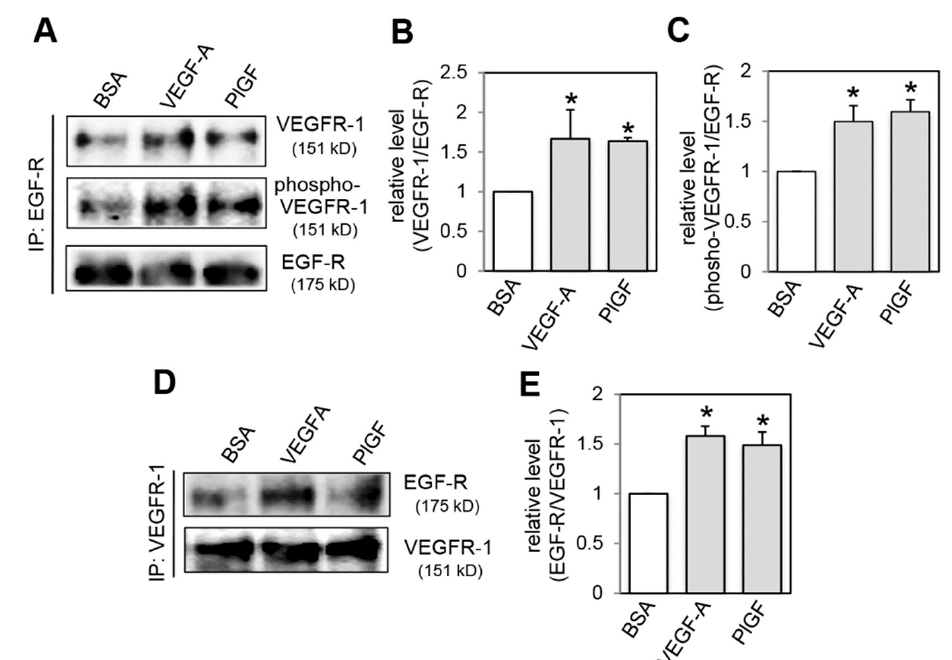
Figure 4. VEGFR-1 activation increases complex formation of VEGFR-1 and EGF-R. ( A ) Cells were treated with BSA, VEGF-A or PlGF for 30 min. Cell lysates were immunoprecipitated with an anti-EGF-R antibody (IP: EGF-R) and then immunoblotted for VEGFR-1 ( A , upper panel) and for phosphorylated VEGFR-1 ( A , middle panel). In parallel, Western blot was performed to control for EGF-R concentration in the immunoprecipitates ( A , lower panel). ( B , C ) Quantification of co-immunoprecipitated VEGFR-1 levels ( B ) and phosphorylated VEGFR-1 levels ( C ) normalized to immunoprecipitated EGF-R levels from three independent experiments. * p < 0.01, statistically significant increase compared with the BSA-treated control. ( D ) Cells were treated with BSA, VEGF-A or PlGF for 30 min. Cell lysates were immunoprecipitated with an anti-VEGFR-1 antibody (IP: VEGFR-1) and then immunoblotted for EGF-R ( D , upper panel). In parallel, Western blot was performed to control for VEGFR-1 concentration in the immunoprecipitates ( D , lower panel). ( E ) Quantification of co-immunoprecipitated EGF-R levels normalized to immunoprecipitated VEGFR-1 levels from three independent experiments. * p < 0.01, statistically significant increase compared with the BSA-treated